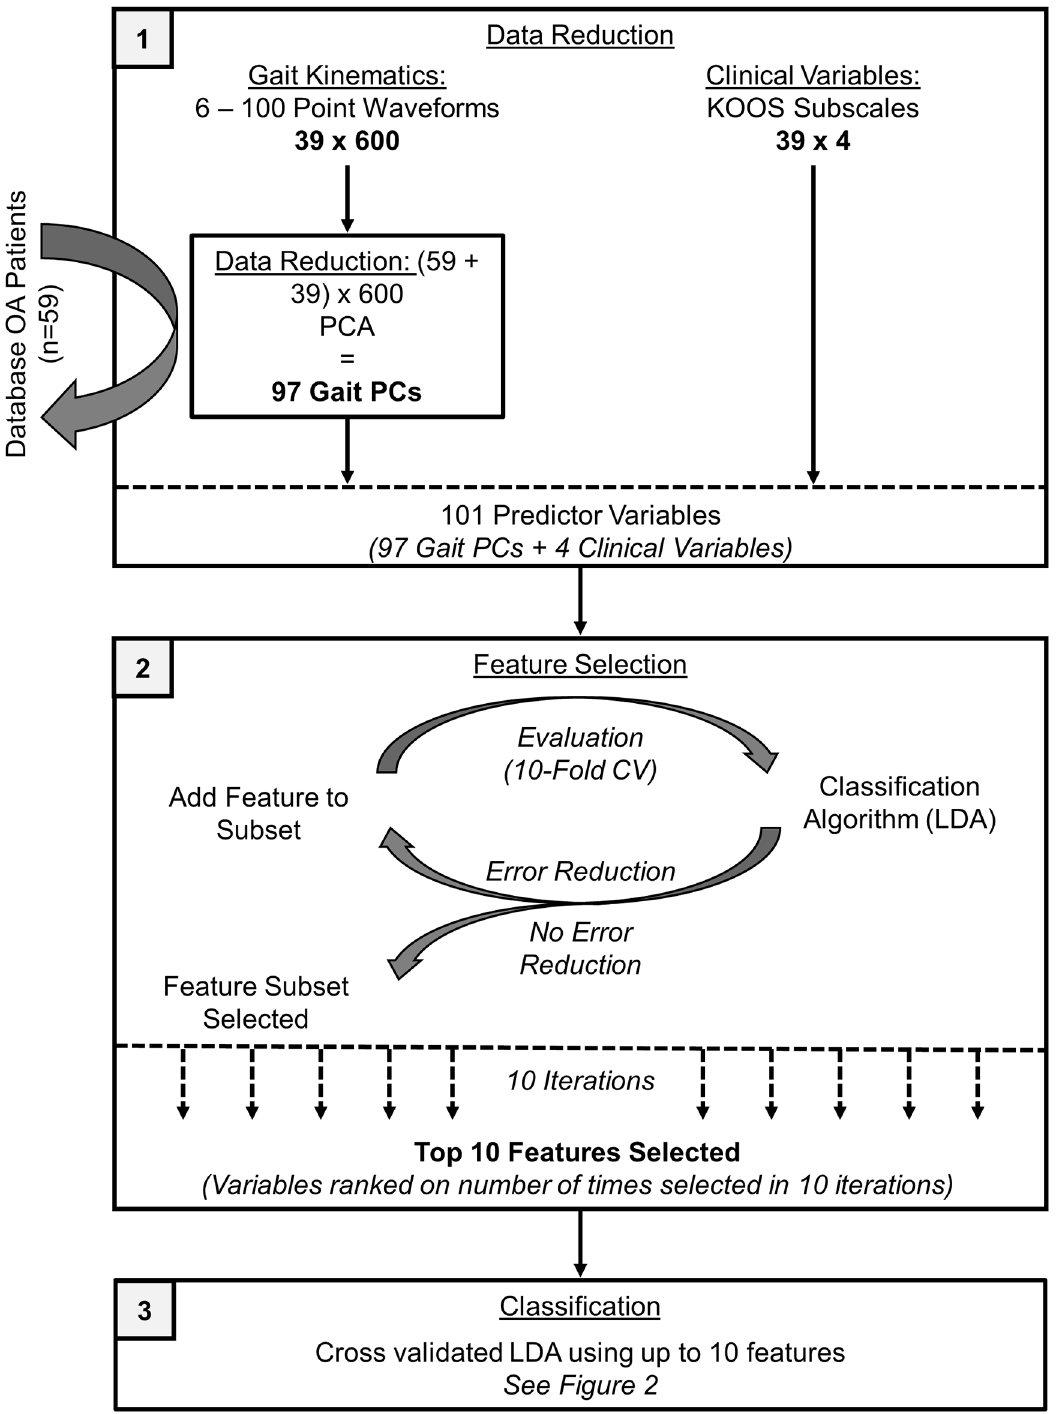
Fig 3. Three primary steps involved in data analysis for the classification of responder subgroups; data reduction, feature selection, and classification.